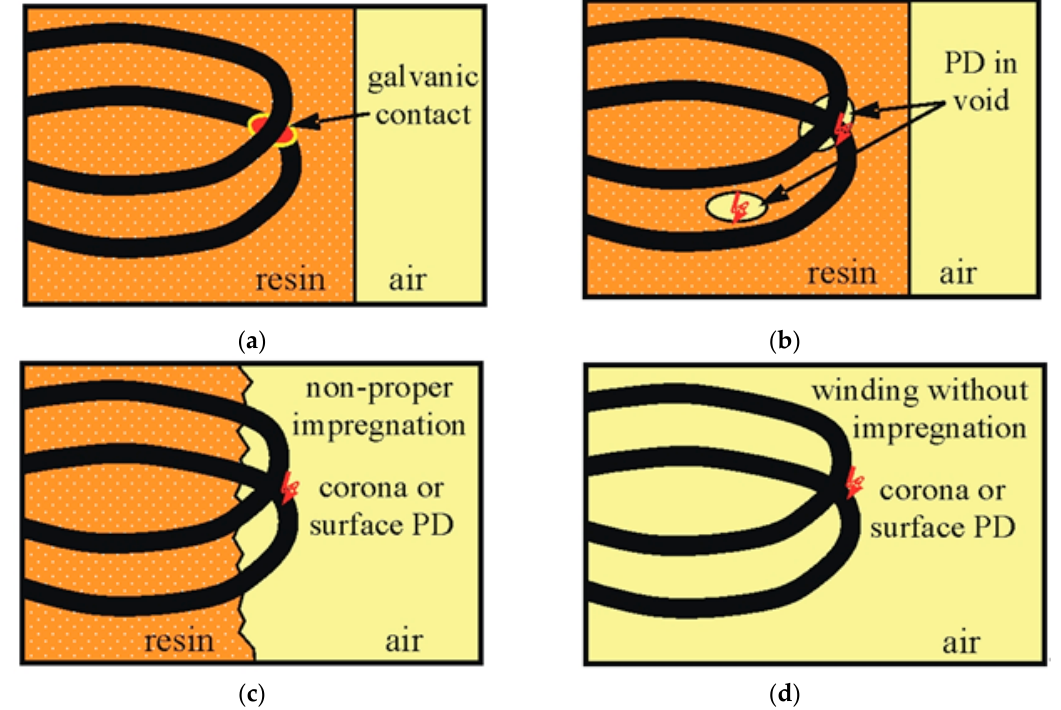
Figure 3. Specific defects of random ‐ wound windings insulating systems: ( a ) turns short ‐ circuit, ( b ) gaseous void between or adjacent to winding wires, ( c ) and ( d ) corona or surface discharges at contacting wires in air.